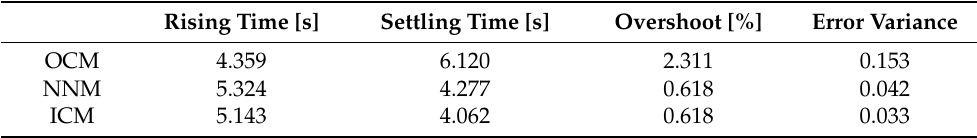
Table 8. Tracking performance indexes of three control